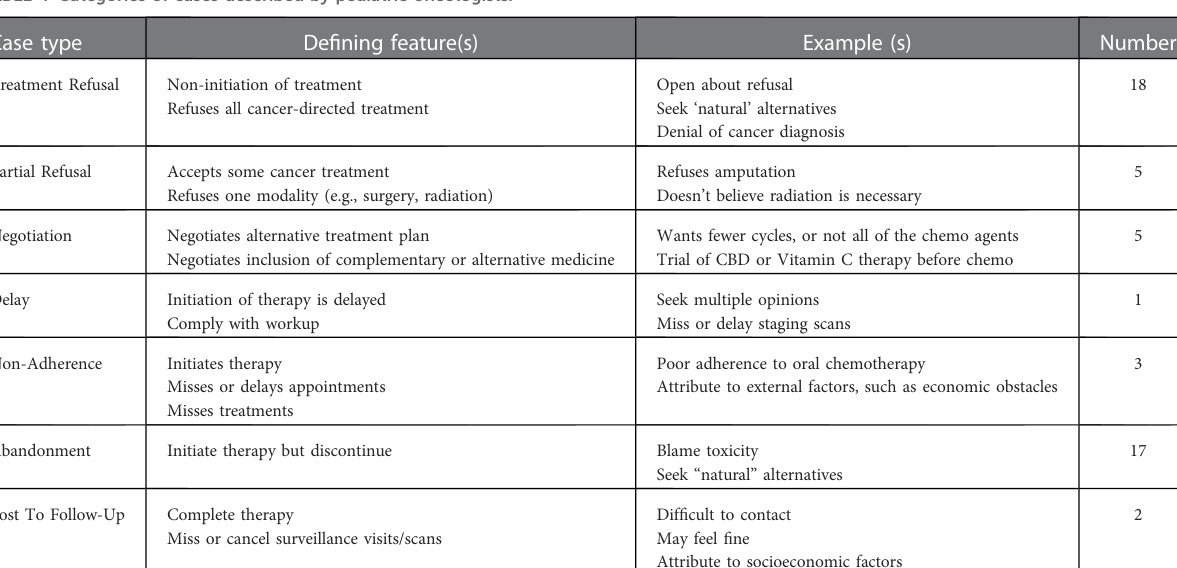
TABLE 4 Categories of cases described by pediatric